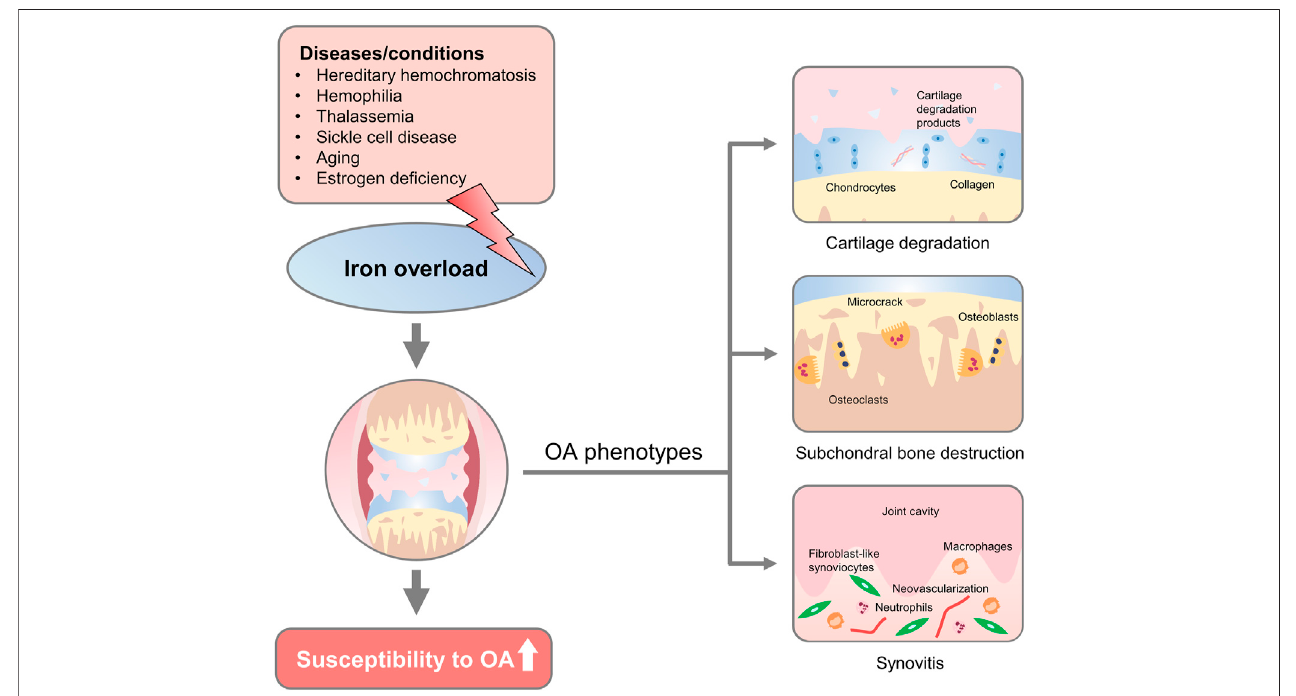
FIGURE 1 | Overview of iron overload etiologies and osteoarthritic phenotypes. Diseases/conditions with diverse etiology, such as hereditary hemochromatosis, hemophilia, thalassemia, sickle cell disease, aging, and estrogen de fi ciency could lead to iron overload in the human body. Changes that affect iron overload in the joint increase the susceptibility to developing osteoarthritic phenotypes, including progressive cartilage degradation, altered microarchitecture and biomechanics of subchondral bone, and persistent joint in fl ammation, proliferative synovitis, and synovial pannus.